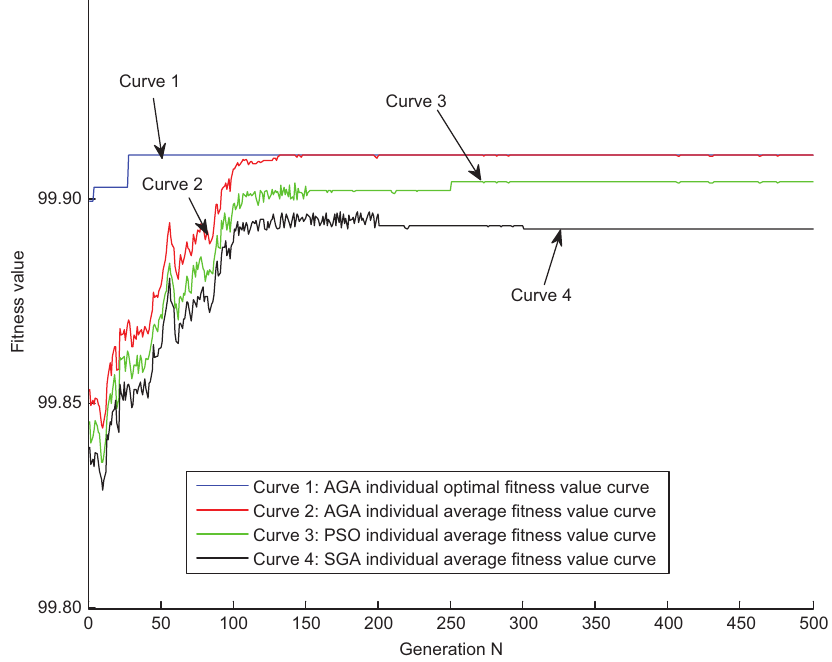
Figure 5. The Operation Results of AGA, PSO, and